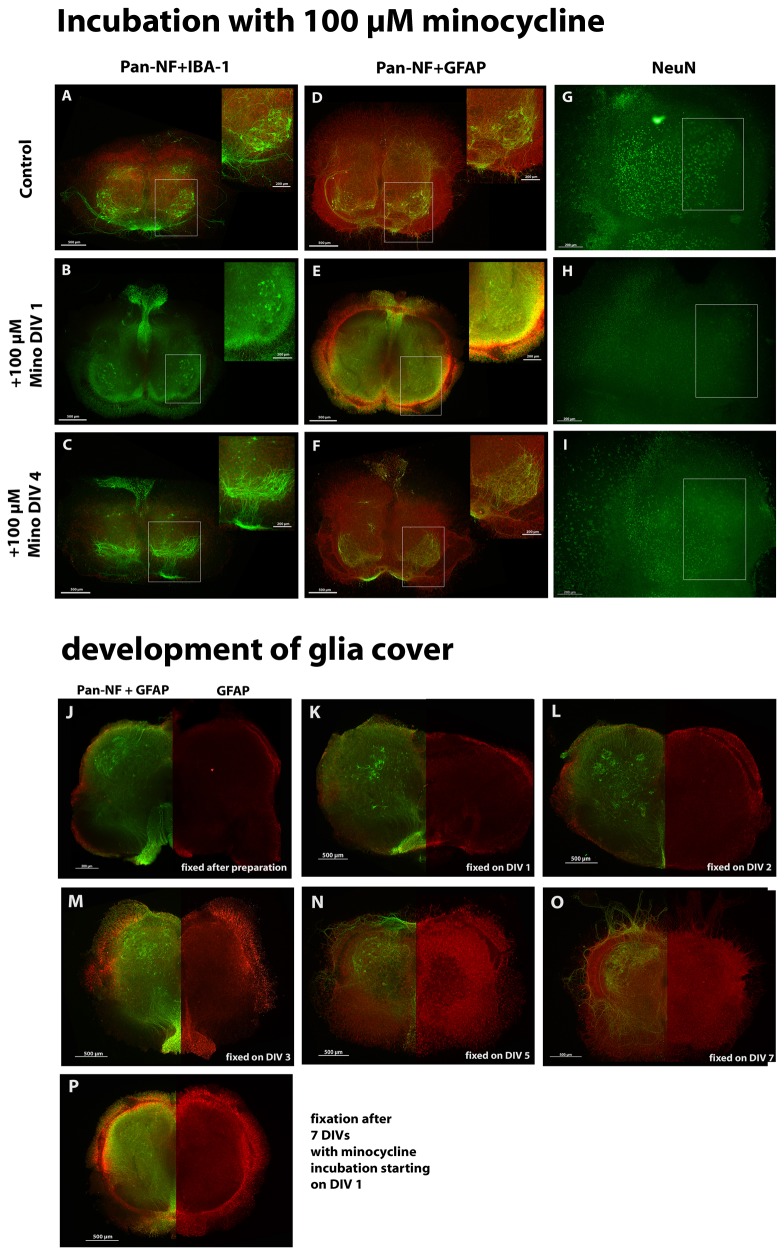
Fluorescence images of spinal cord cultures treated with 100 µM minocycline.(A, D, G) controls; (B, E, H) incubation starting at DIV 1; (C, F, I) incubation from DIV 4 onwards. Slices were co-stained for anti-pan-NF (green) and anti-IBA-1 (red) in (A, B, C), for anti-pan-NF (green) and anti-GFAP (red) in (D, E, F) or for anti-NeuN (green) in (G, H, I). Motor neuronal areas are magnified in (A–F) and marked with a box (A–I). (A) Control cultures show various anti-pan-NF stained motor neurons, neurons, modest microglia activation, (D) glia cover formation and (G) anti-NeuN stained neuron populations. Cultures treated from DIV 1 onwards displayed (B) a lack of motor neurons and microglial staining, (E) a peripheral astroglial distribution and (H) a lack of anti-NeuN stained neurons. Cultures treated from DIV 4 onwards showed (C) less motor neurons and low microglia activation, (F) the formation of a glia cover on the slice surface and (I) some anti-NeuN stained neurons. Images (J–O) illustrate the development of the glia cover during cultivation. Slices are shown double stained with anti-pan-NF and anti-GFAP on the left and anti-GFAP staining only on the right. (J) displays a slice fixed after preparation (no cultivation). A peripheral anti-GFAP staining is visible. Slices were fixed and stained after 1 DIV (K), 2 DIV (L), 3 DIV (M), 5 DIV (N) or 7 DIV (O) of cultivation. The glial distribution changes over time from a peripheral distribution to a glia cover. Bars in (A–F, J–P) = 500 µm and in magnified area = 200 µm. Bars in (G–I) = 200 µm.